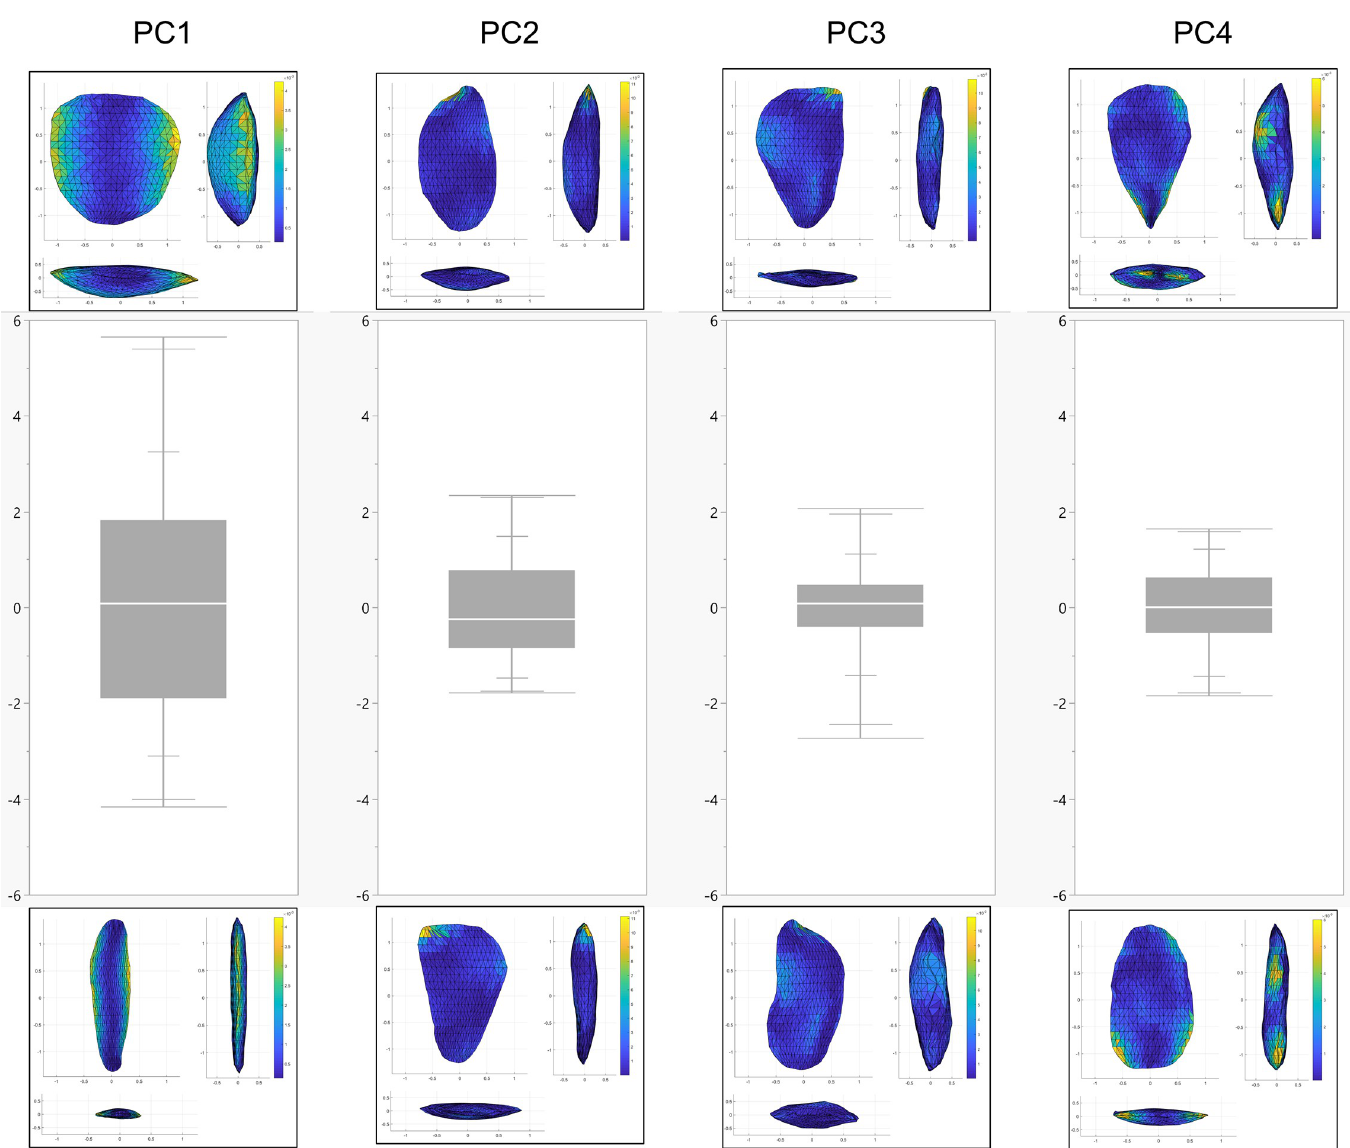
Fig 36. Distribution of the bifaces across each of the first four principal components. Box plots are quantile, blank line is the median. The figures at the top and bottom of each plot represent hypothetical items at the extremity of the principal component to visualize the shape trend. Color scales reflect the proportional spatial distribution of variability on each shape trends (i.e., the areas that change the